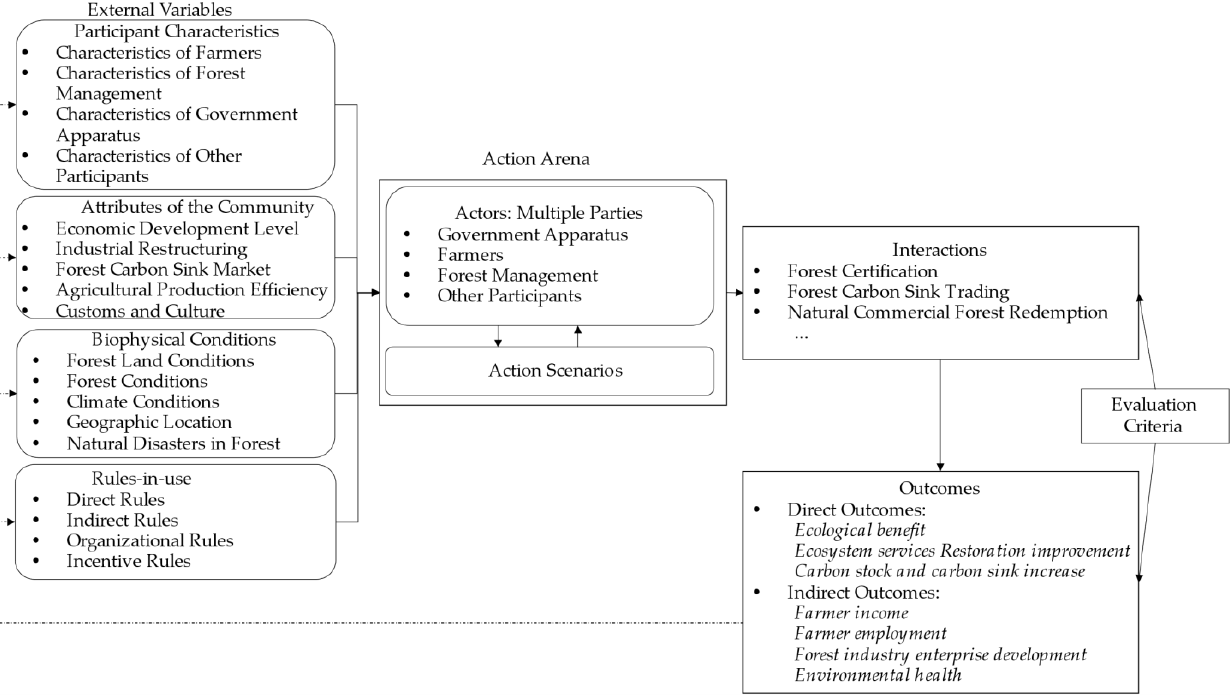
Figure 3. Influencing factors and outcomes of multiple parties’ participation in NFPR.